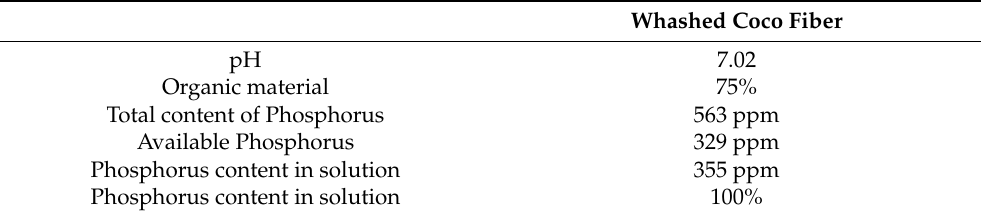
Table 2. Physicochemical properties of washed coconut fiber with a focus on phosphorus